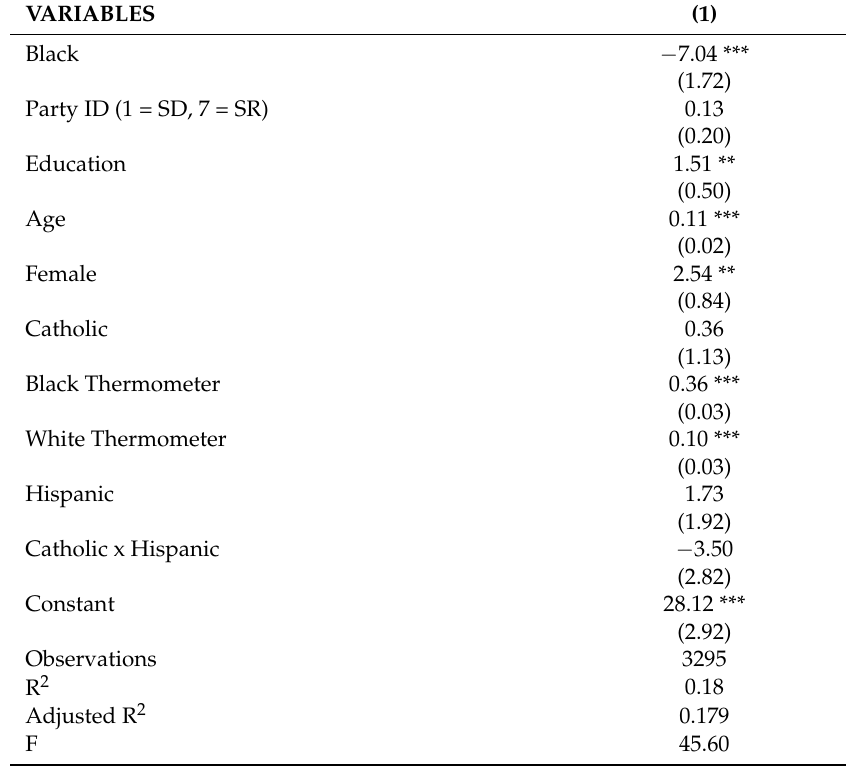
Table 5. Impact of Hispanic versus Catholic on the Jewish thermometer rating, 2016 ANES.